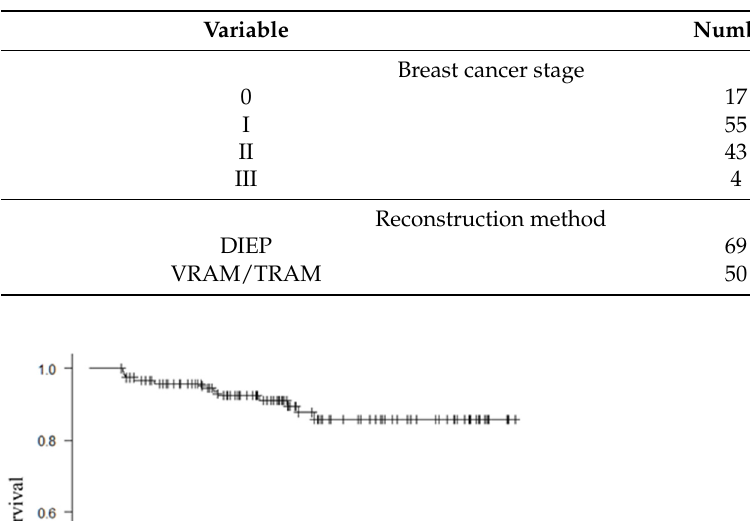
Table 1. Patients’ background characteristics.